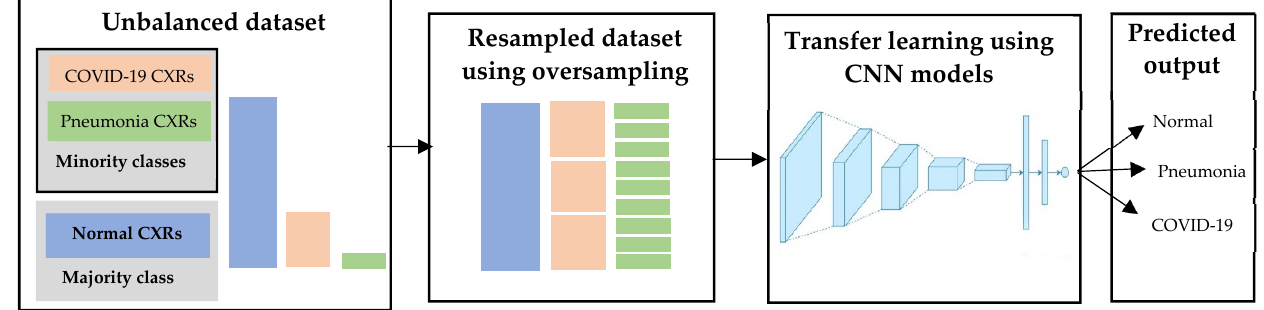
Figure 12. Deep learning with oversampling on the unbalanced dataset. COVID-19 and pneumonia CXRs were randomly duplicated to ensure a better balance with the number of normal CXRs.